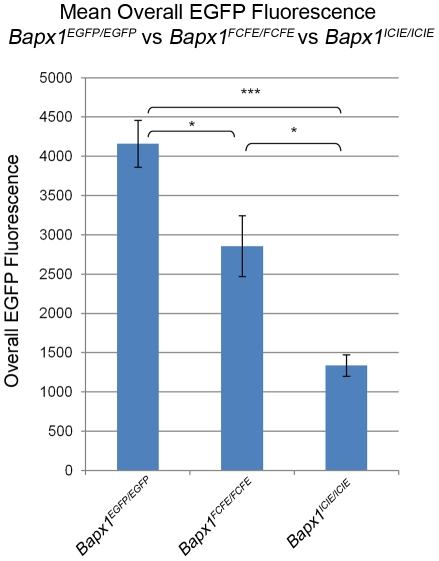
Mean overall EGFP fluorescence of E12.5 Bapx1EGFP/EGFP, Bapx1FCFE/FCFE and Bapx1ICIE/ICIE embryos.Mean overall EGFP fluorescence of E12.5 Bapx1EGFP/EGFP (4159.56±297.81; n = 7), Bapx1FCFE/FCFE (2856.74±387.58; n = 11) and Bapx1ICIE/ICIE (1338.13±137.83; n = 9) embryos analyzed by flow cytometry. Overall EGFP fluorescence was calculated by multiplying MFI and percentage of EGFP-positive cells. Two-tailed Student's T test, *p<0.05, ***p<0.0001.